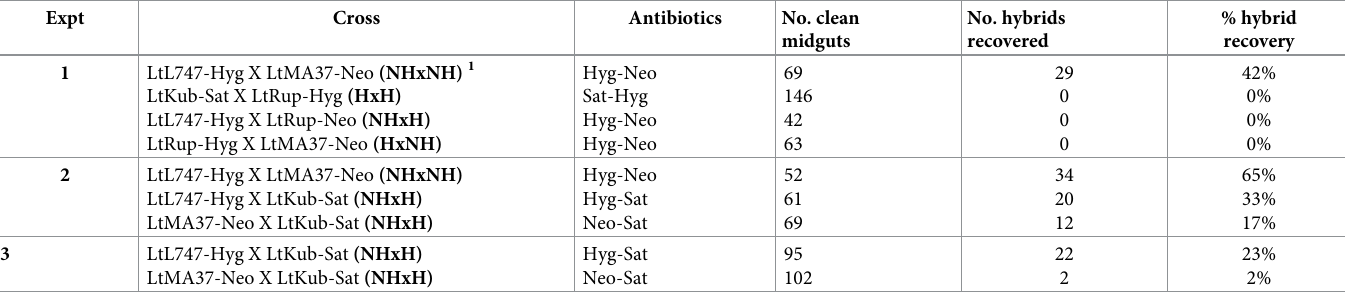
Table 3. Crosses in Lu . longipalpis involving L . tropica